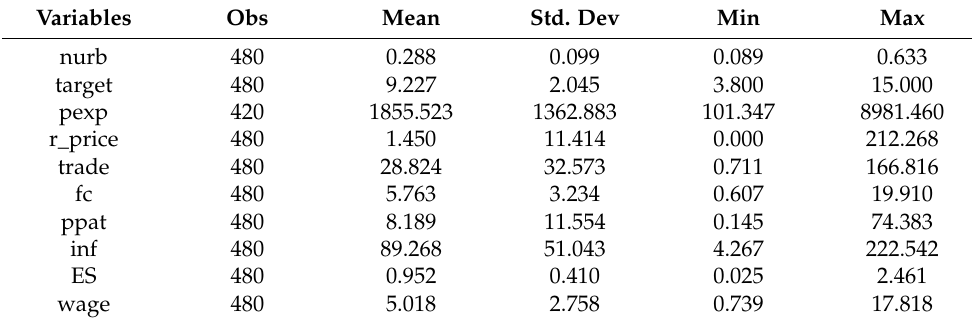
Table 2. Descriptive statistics of variables.